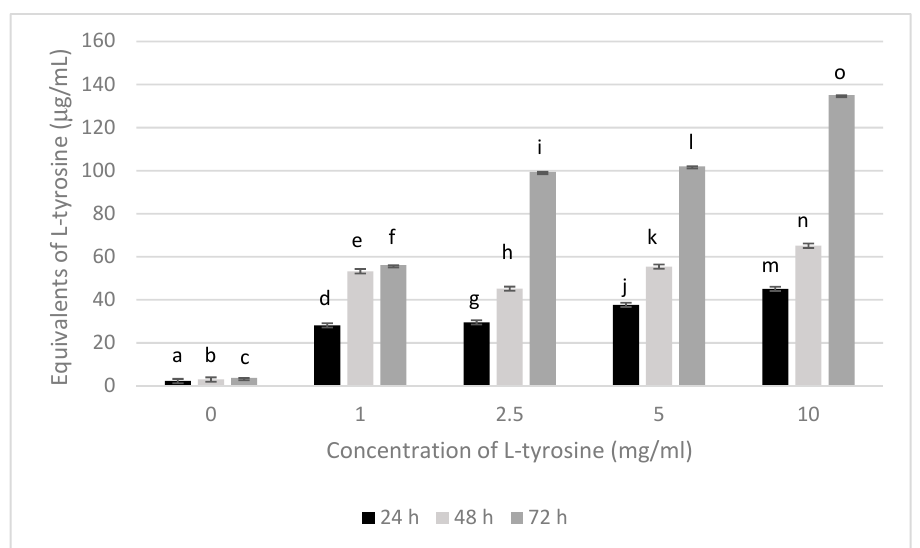
Figure 4. Total polyphenols present in melanin produced by Pseudomonas putida ESACB 191 with